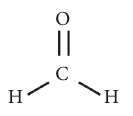
Figure 1: Chemical structural of